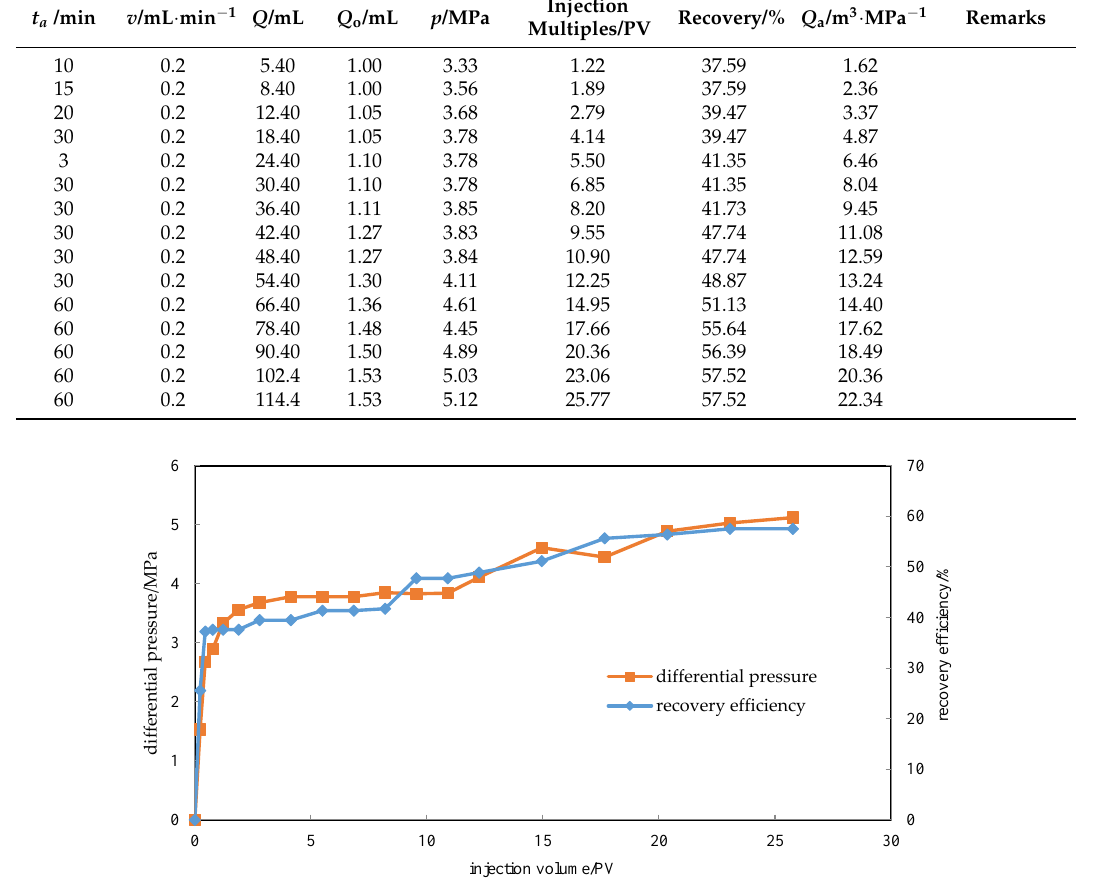
Figure 8. Pressure differential, recovery relationship of multiple injections.